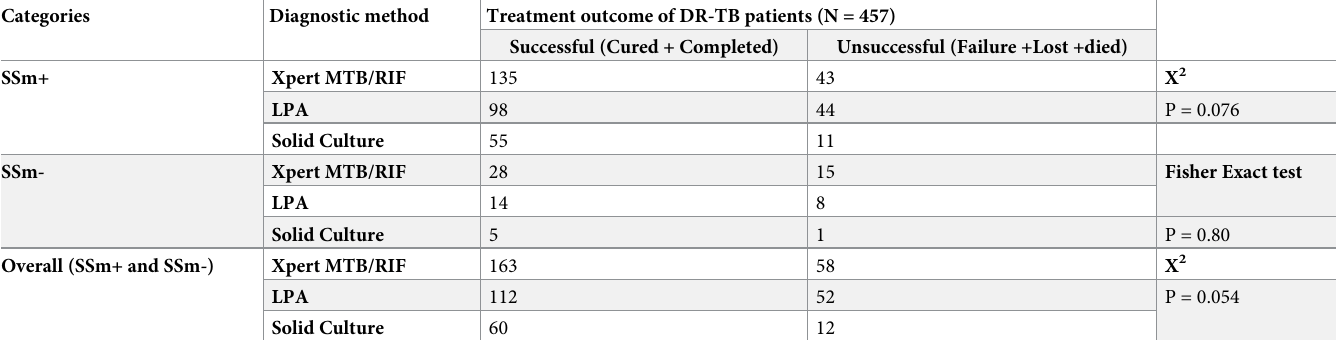
Table 4. Treatment outcomes of DR-TB based on the diagnostic methods stratified by their sputum smear result in the Amhara Region, Ethiopia.